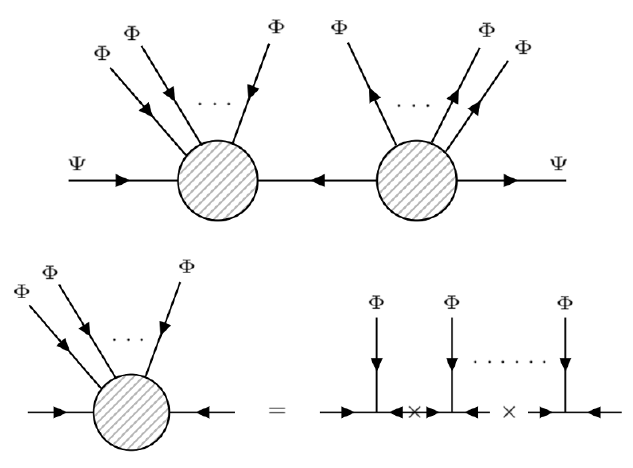
Figure 2 . Supergraphs which correct the K(cid:127)ahler potential.